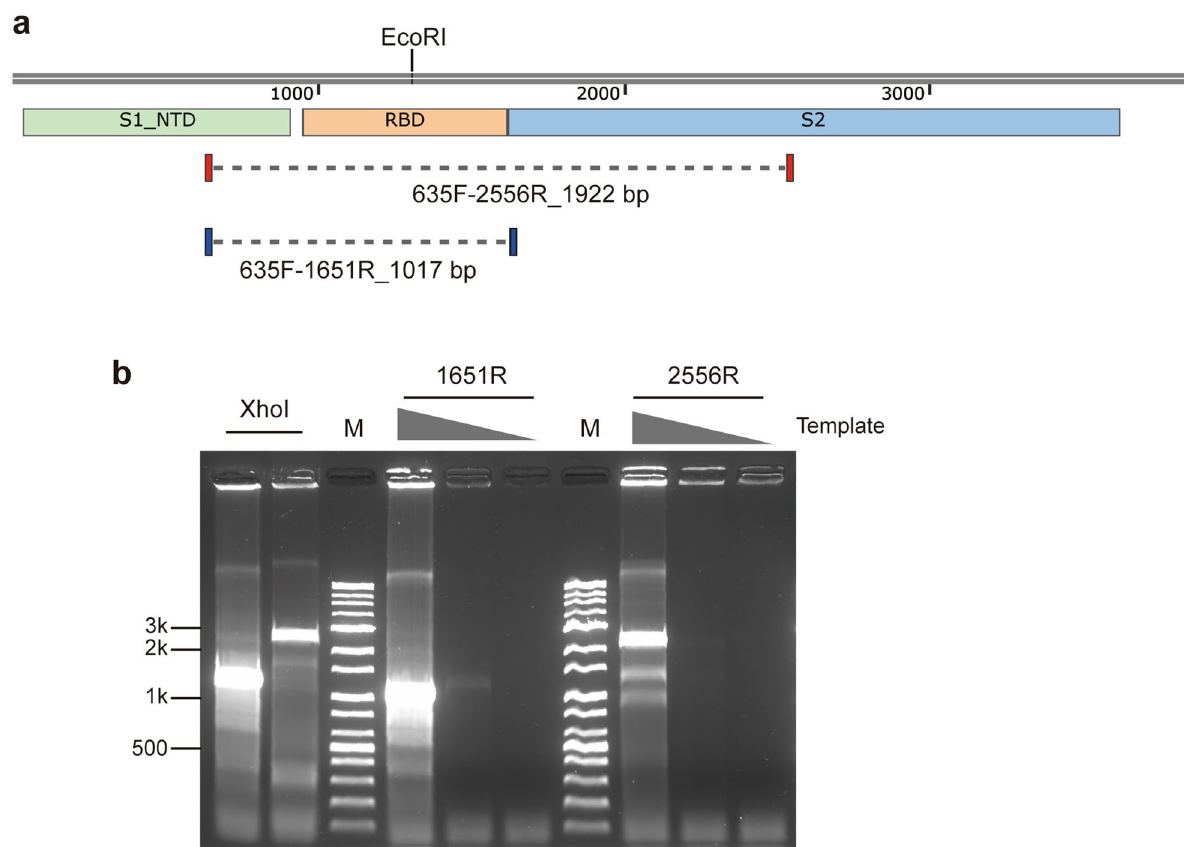
Figure 3. CREA targeting SARS-CoV-2 spike . ( a ) Position of loxP-primers and target length of each primer sets are designated. Domains of Spike and position of selected restriction enzyme (EcoRI) is also marked. ( b ) CREA reaction by primer sets using different template copies of 5 × 10 10 , 7 × 10 9 and 7 × 10 8 . 635F-1651R pair was used for RCA primer. For XhoI cut set (from left, 1651R and 2556R), 5 × 10 10 copies of template were used. Sizes of some marker bands are indicated. M; marker. Because of non-uniform incorporation of SYBR green I added to the sample before gel loading, inaccurate migration